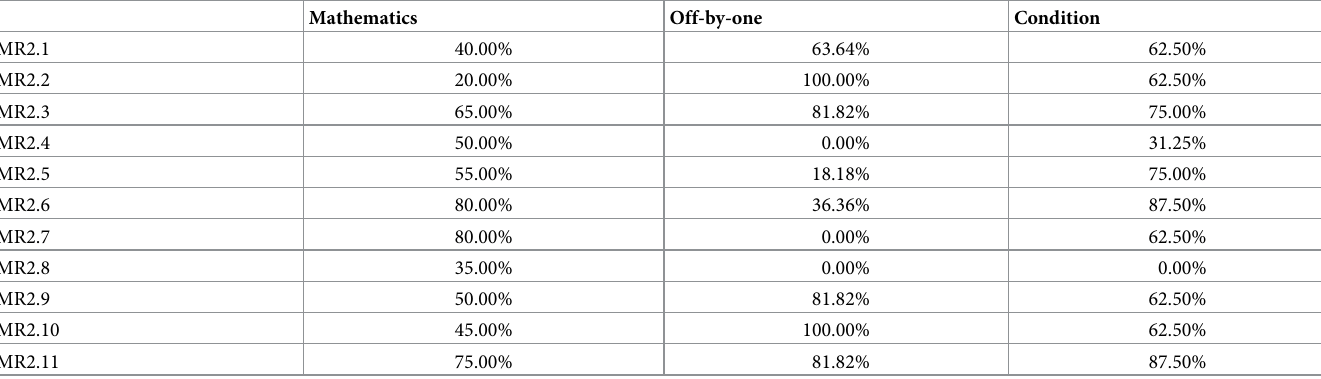
Table 10. Mutation scores of MRs for the counter deposit event for different types of mutants.